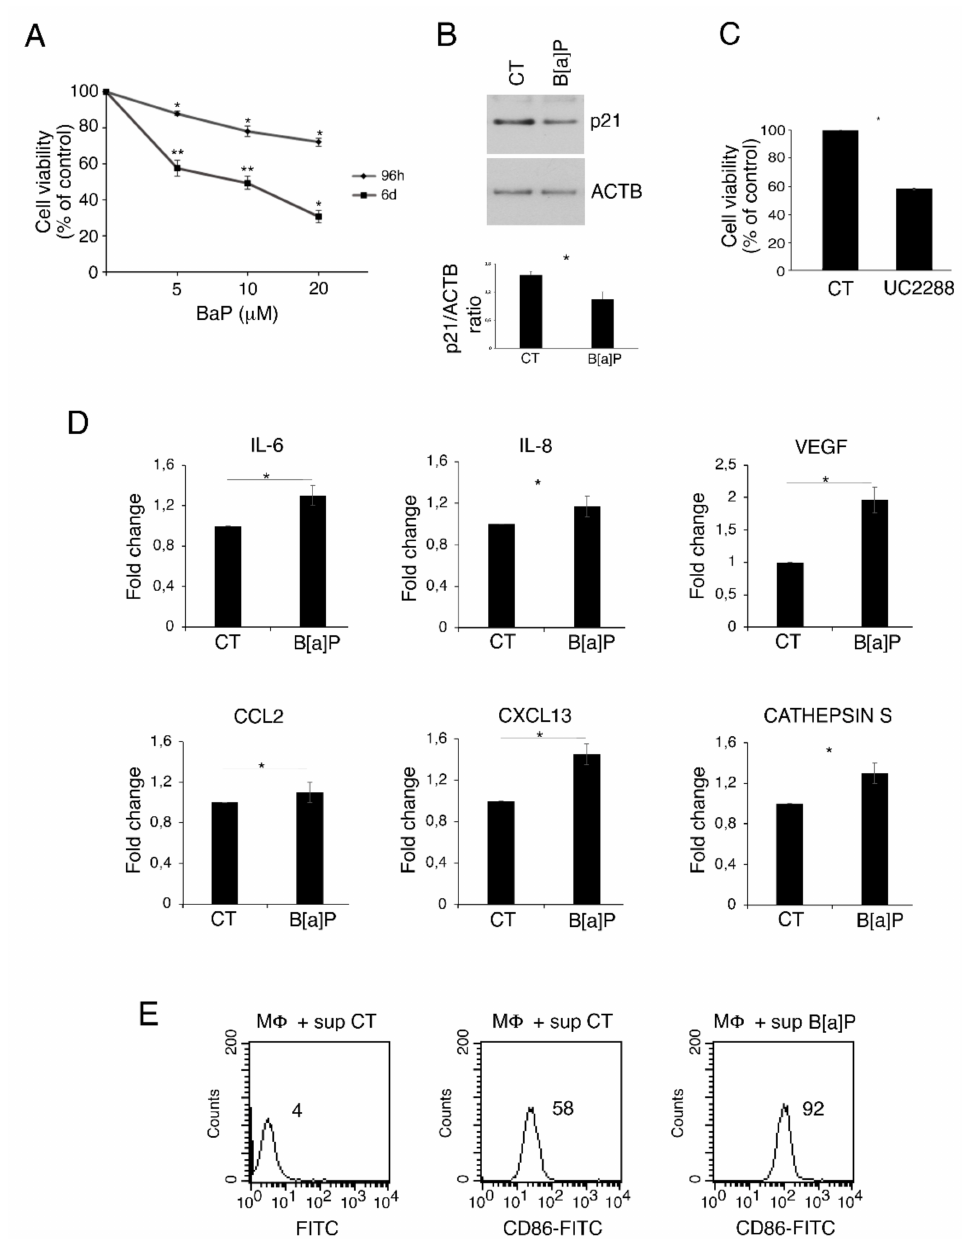
Figure 1. B[a]P reduces cell viability in HCoEpC through p21, induces pro-inflammatory cytokines and activates macrophages. ( A ) % of cell viability of HCoEpC treated with different B[a]P